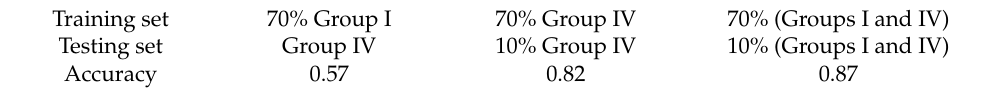
Table 11. Accuracy results of Group IV.